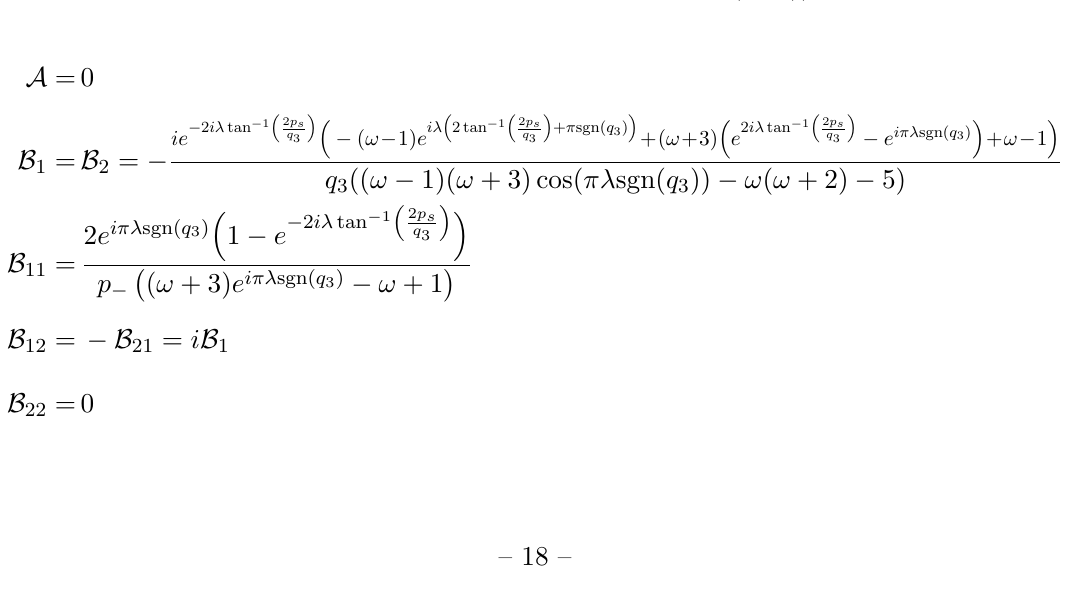
J ¯ΦΦ (cid:31) (cid:30)